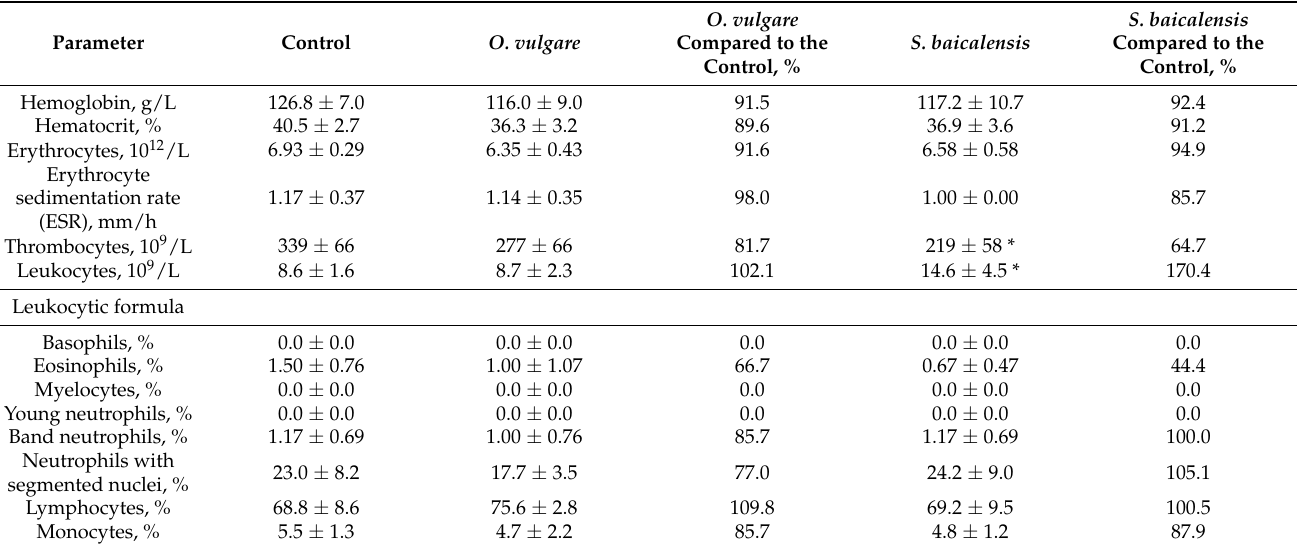
Table 6. Changes observed in the general analysis of the blood and leukogram of the male rats under effects of the addition of Origanum vulgare L. and Scutellaria baicalensis Georgi to their diet (x ± SD, n = 8, duration of experiment—30